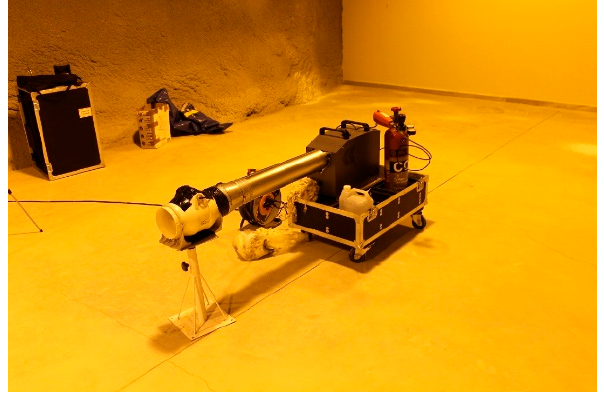
Figure 15. Exit route during second evacuation drill (smoke environment).